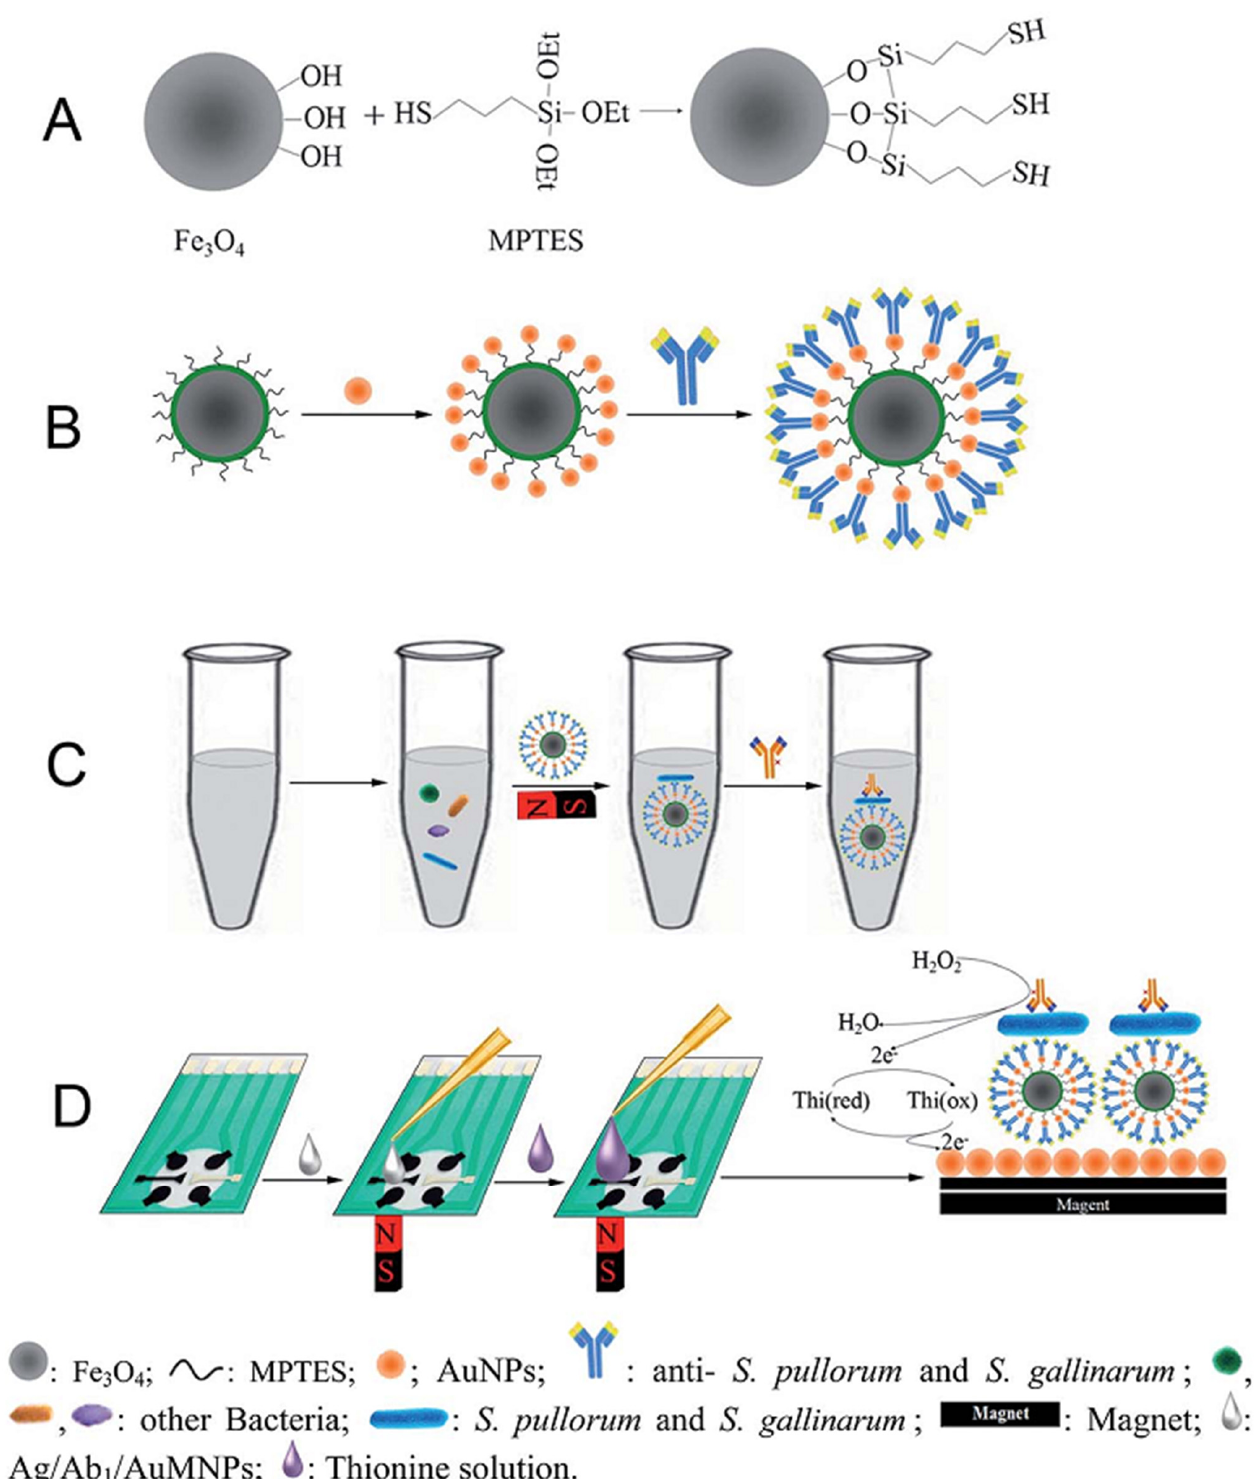
Figure 7. Schematic of the modification process of the electrochemical immunoassay and the detec- tion mechanism: ( A ) the synthesis process of the Fe 3 O 4 /SiO 2 –SH nanoparticles; ( B ) the synthesis process of Ab 1 /AuMNPs; ( C ) the process of S. pullorum and S. gallinarum being captured from the samples by Ab 1 /AuMNPs and the formation of HRP-Ab 2 /Ag/Ab 1 /AuMNPs; ( D ) HRP- Ab 2 /Ag/Ab 1 /AuMNPs dropped on AuNPs/4-SPCE, which is the principle of electrochemical detec- tion (adapted and reprinted with permission from [122]).